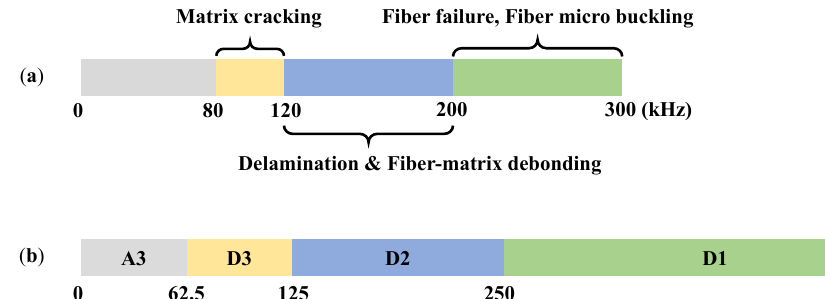
Figure 12. Frequency contents of elastic wave according to: ( a ) failure mechanisms in carbon fiber reinforced plastic (CFRP) cross-ply laminates by Arumugam et al. [36] and ( b ) coefficients of a PVDF sensor signal acquired by three-level DWT.